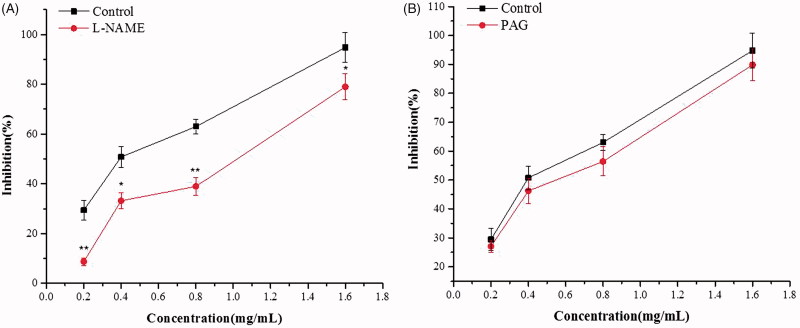
Effects of different inhibitors on ALR-induced relaxation in rat-isolated jejunum. (A) Effect of l-NAME 10–4 M on ALR-induced relaxation. (B) Effect of PAG 10–5 M on ALR-induced relaxation. Compared with vehicle control group: **p < 0.01. ANOVA followed by Dunnett’s multiple comparison test.